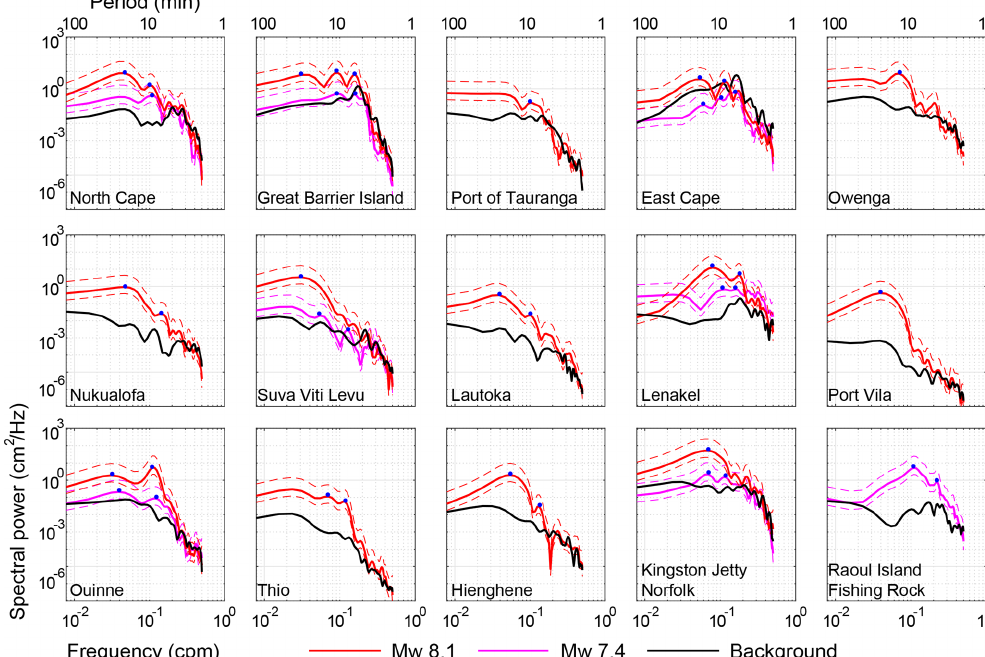
Figure 3. Fourier analyses for tsunamis generated by two successive earthquakes ( M w 7.4 and M w 8.1) in the Kermadec Islands. Pink and red curves represent the spectra of the first tsunami and the second tsunami, respectively. Blue dots show the spectral peaks listed in Table 1. The 95% confidence bounds of two tsunami spectra are indicated by dashed curves. The background spectra (black curves) are also plotted for comparison.